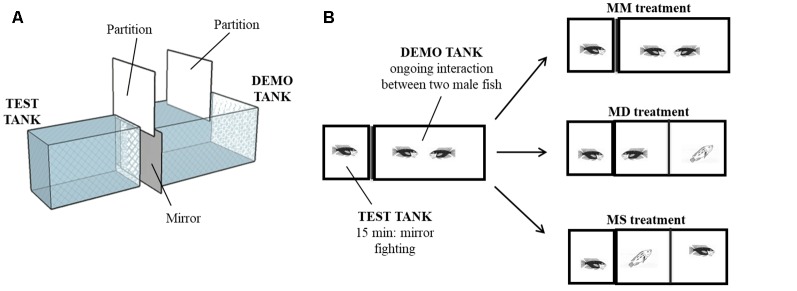
Behavioral paradigm. (A) 3D diagram of the experimental setup. Test tank and demo tank were side-by-side and physically separated. (B) Schematic of the experimental treatments. Focal fish interacted with a mirror for 15 min while two males were fighting in the adjacent compartment. Then, focal fish were allowed to see for 2 min its own image in the mirror (MM treatment), a dominant male (Mirror becomes Dominant—MD treatment) or a subordinate male (Mirror becomes Subordinate—MS treatment).